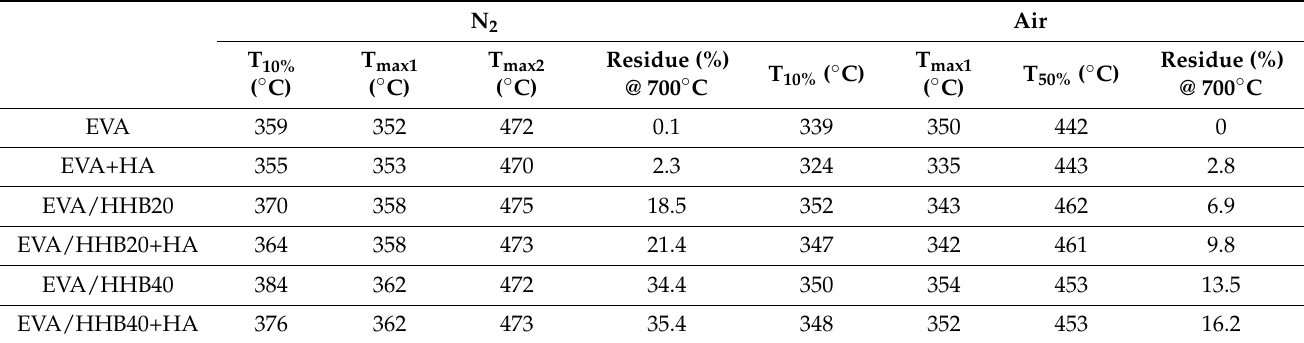
Table 2. Results from thermogravimetric analyses for EVA and its